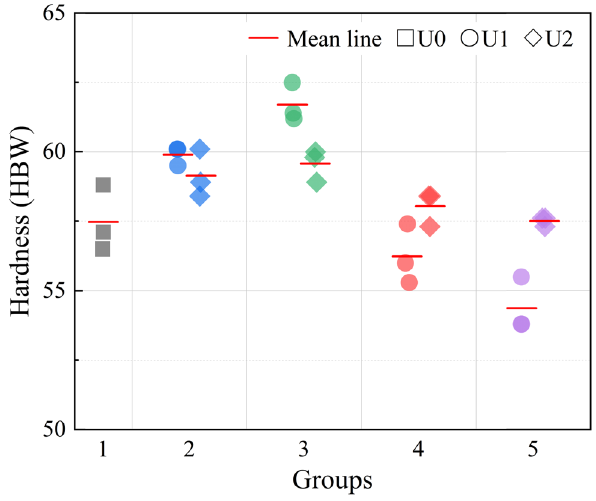
Figure 9: Comparison of the Brinell hardness values of the casting samples in di ff erent